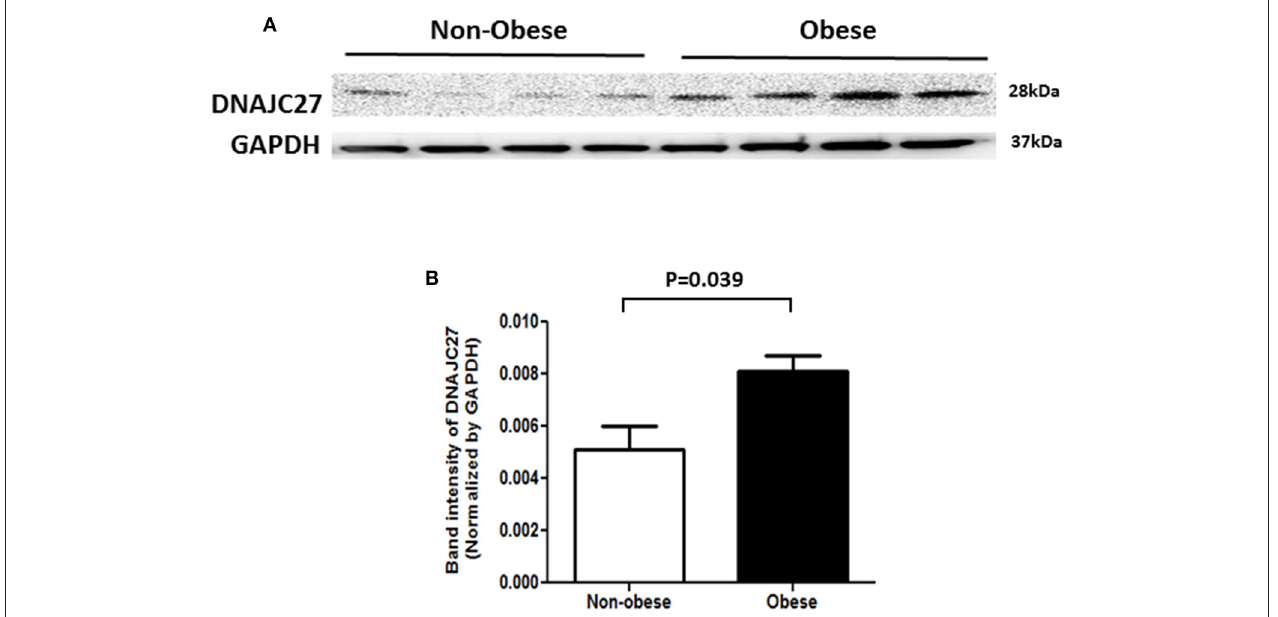
FIGURE 2 | Western Blot analysis of protein from PBMCs of Non-obese and obese individuals that were Non-diabetic. ( n = 4 each group). (A) Western blot image. (B) Band intensity quantified after normalizing with GAPDH.